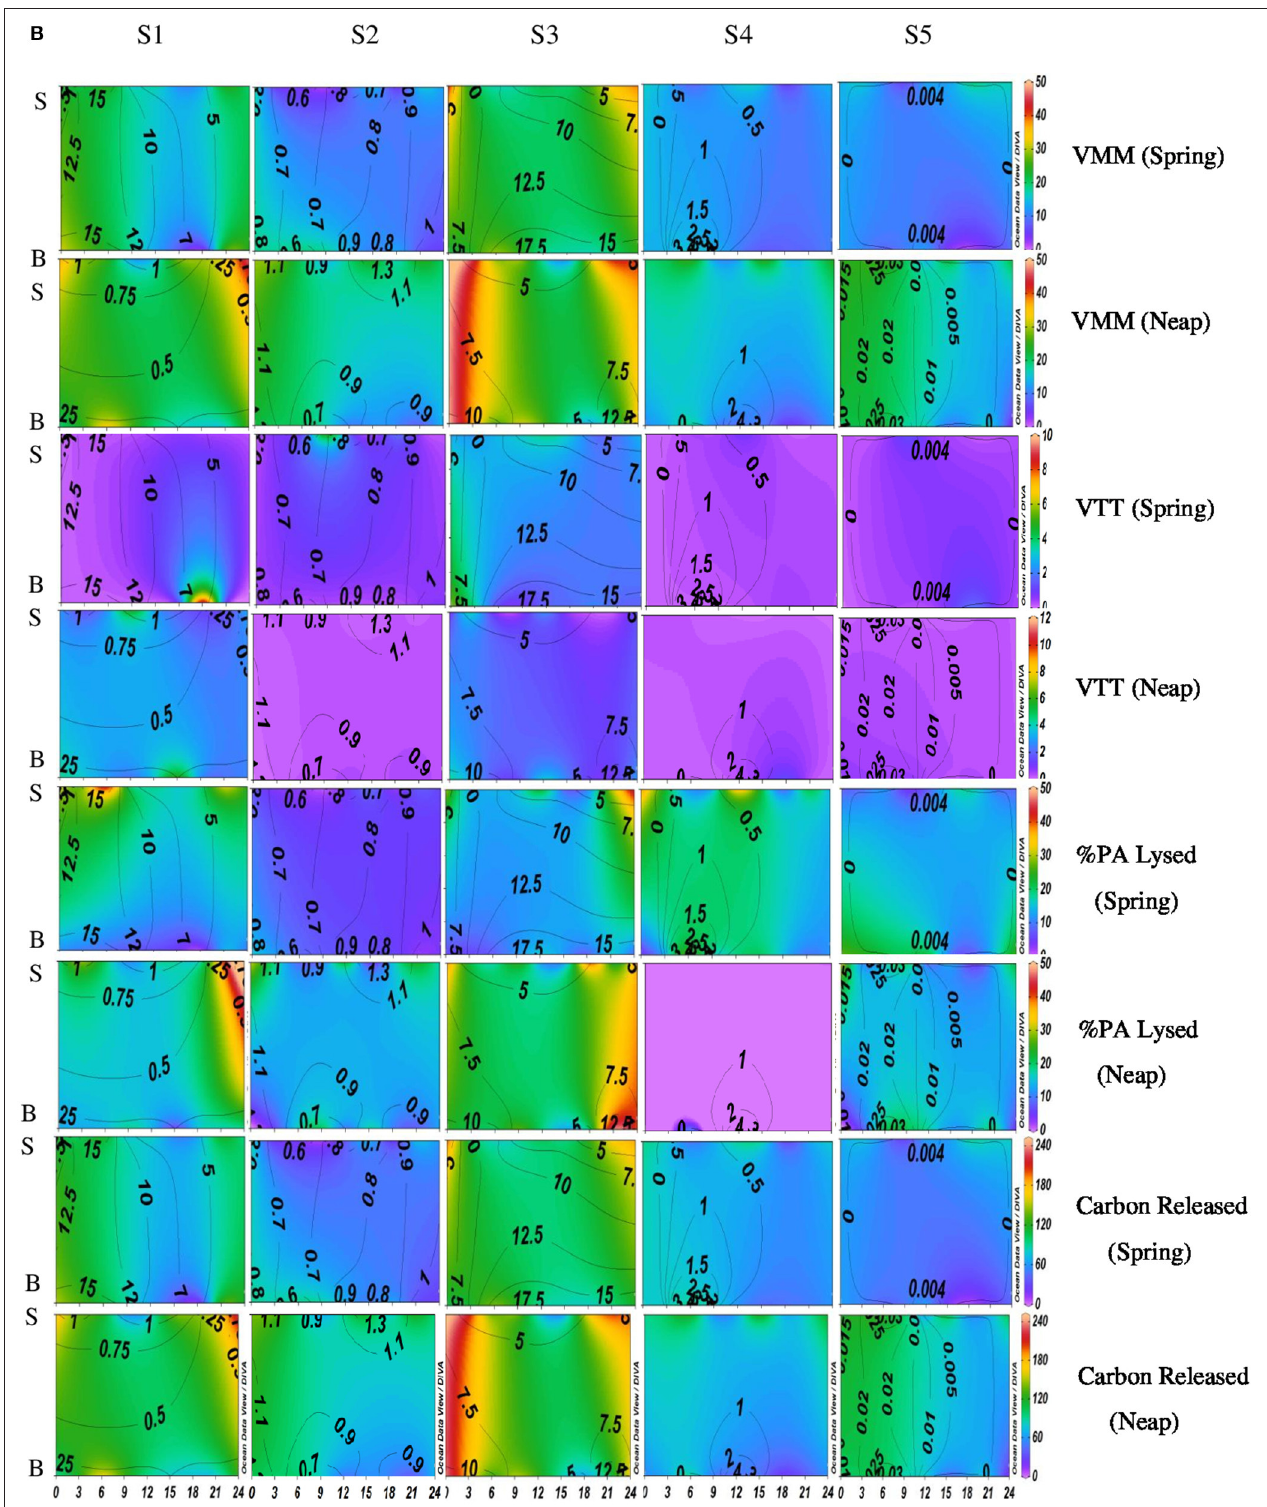
FIGURE 2B | Temporal variations (diel and tidal) in biological parameters during monsoon (MON) in CE. X- axis represents the time series observations from 00:00 to 24:00 h and Y-axis represent the vertical section of the water column (S, Surface; B, Bottom). Z-axis represent different parameters in color contours and salinity is superimposed as the line contours. The vertical panels S1, S2, S3, S4, and S5 represents the five stations. The horizontal panels represent various parameters during MON, such as, Viral-mediated mortality (VMM%), Viral turnover time (VTT) (d − 1 ), % of BA lysed, and Carbon released ( µ g/C/L/day) during spring and neap phases